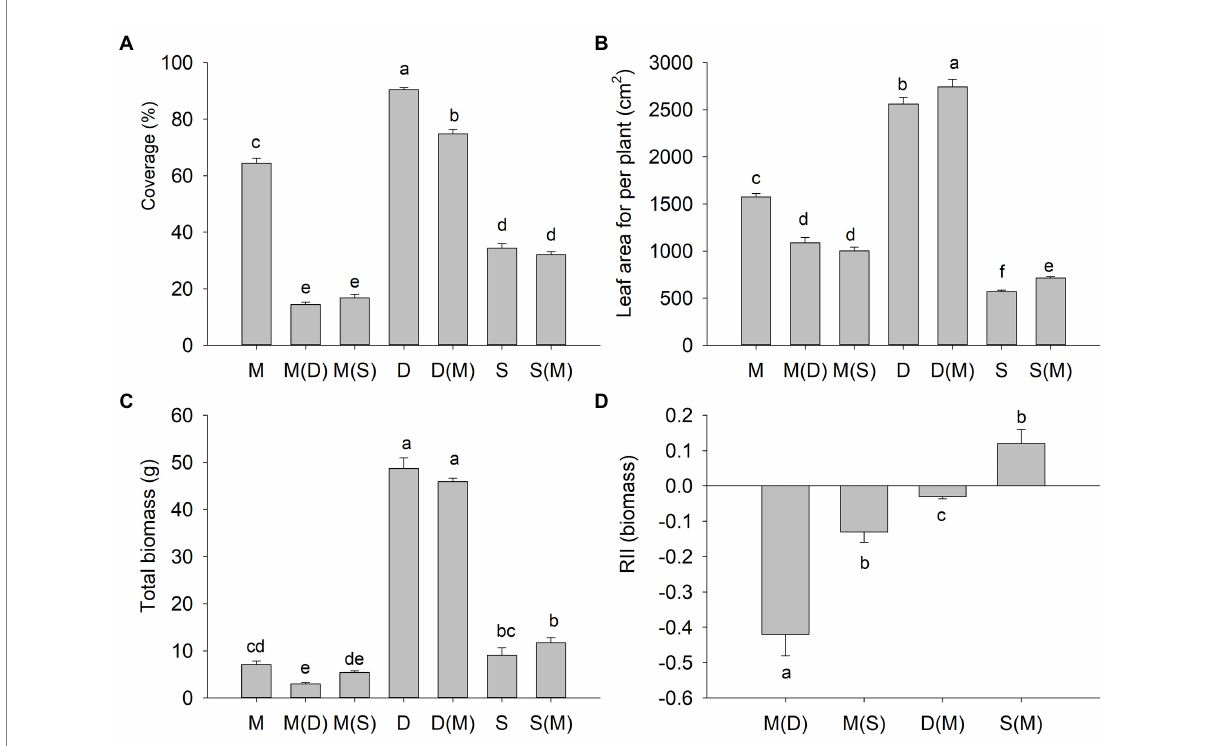
FIGURE 2 Changes of the plant coverage (A) , leaf area (B) , total biomass (C) , and relative interaction index (D) of M. micrantha and the replacement plants under different interspecific competition experiments (average ± SE, n = 4). M(D): M. micrantha when grown under competition with D. heterocarpon ; M(S): M. micrantha when grown under competition with S. tora ; D(M): D. heterocarpon when grown under competition with M. micrantha ; S(M): S. tora when grown under competition with M. micrantha. Different letters above bar plots indicate significant differences (Duncan test, p <